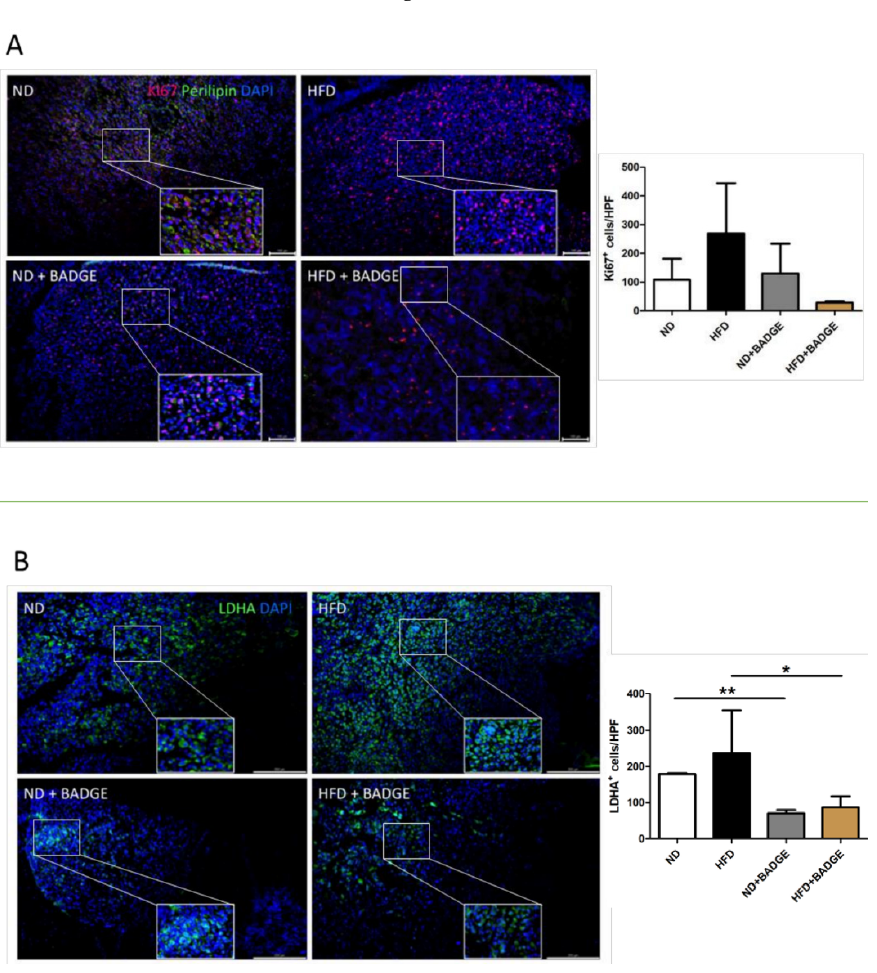
Figure 4. Immunofluorescence staining (rat) for proliferation and glycolysis marker in bone metas- tases after inoculation of MDA-MB 231 breast cancer cells. ( A ) Bone slides of ND, HFD, ND + BADGE, and HFD + BADGE animals were stained for the proliferation marker Ki-67 (red) and the adipocyte marker Perilipin (green). Cell nuclei were counterstained with DAPI (blue). Statistical analysis of Ki-67 + cells/HPF is shown (mean and standard deviation). ( B ) Bone slides of ND, HFD, ND + BADGE, and HFD + BADGE animals were stained for the glycolysis marker LDHA (green). Cell nuclei were counterstained with DAPI (blue). Statistical analysis of LDHA + cells/HPF is shown (mean and standard deviation). * p < 0,05; ** p < 0,01. Scale bar = 100µm.